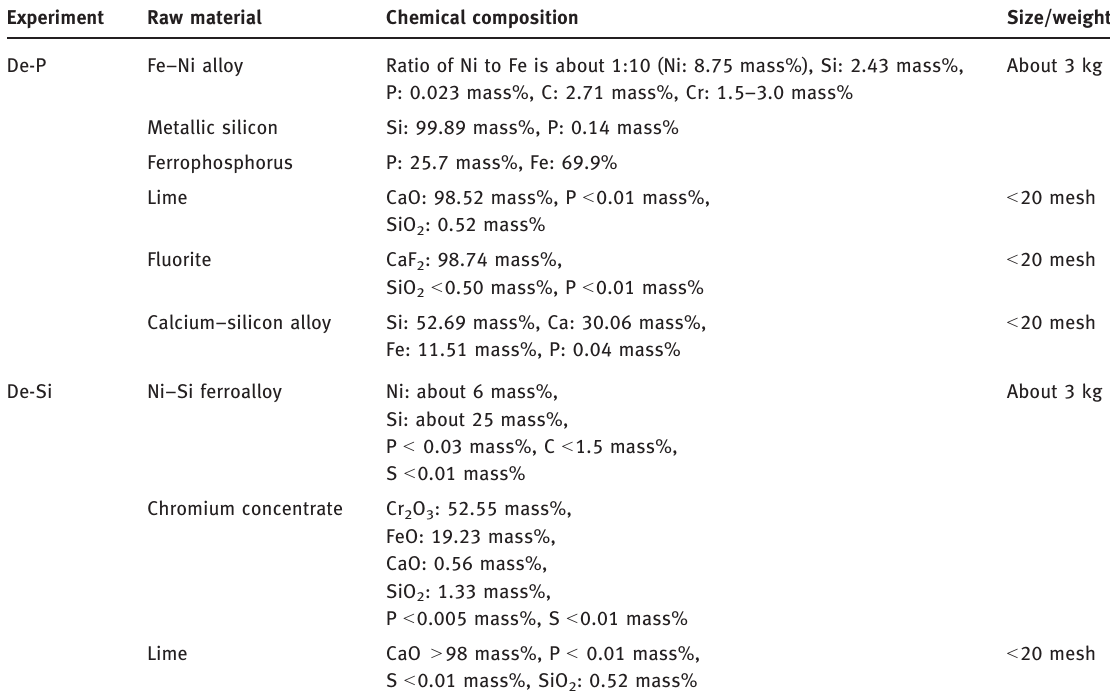
Table 2: Raw materials used in de-P and de-Si experiments.